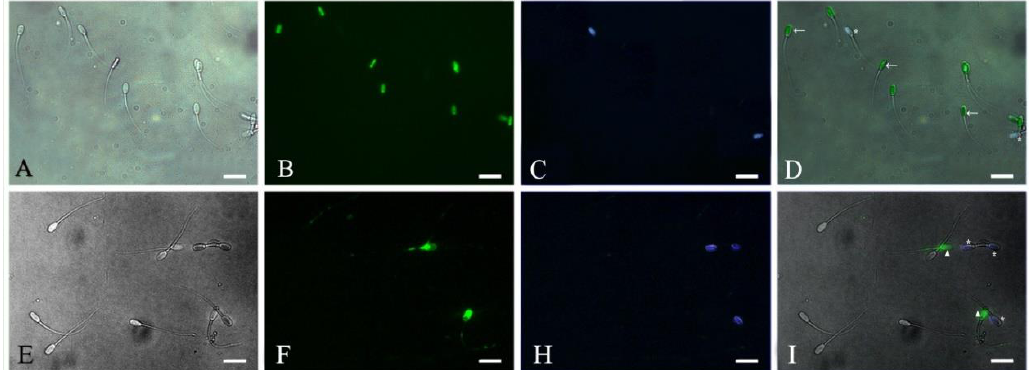
Figure 3. Photomicrographs of early apoptotic and dead sperm. A and E: Light-field phase contrast microscopic image. B: Live sperm with SYBR-14. C and H: Dead sperm with propidium iodide (PI). D: Merge of A, B, and C. F: Early apoptotic sperm with FITC. I: Merge of E, F, and H. Scale bar: 20 µ m. ← : the live sperm. *: the dead sperm. ▲ : the early apoptotic sperm.